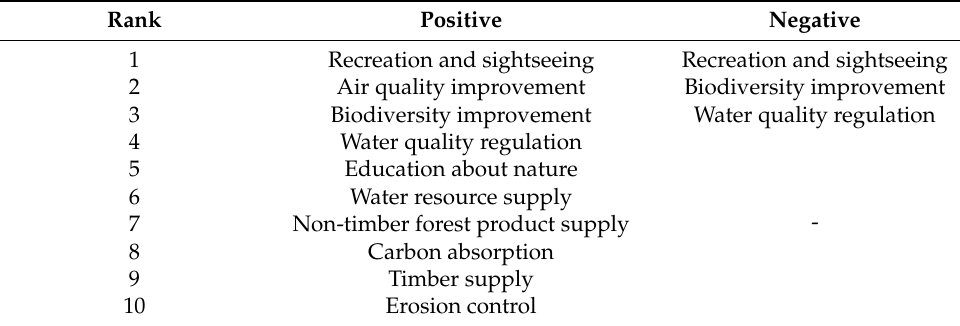
Table 6. Rank by the sentiment analysis in